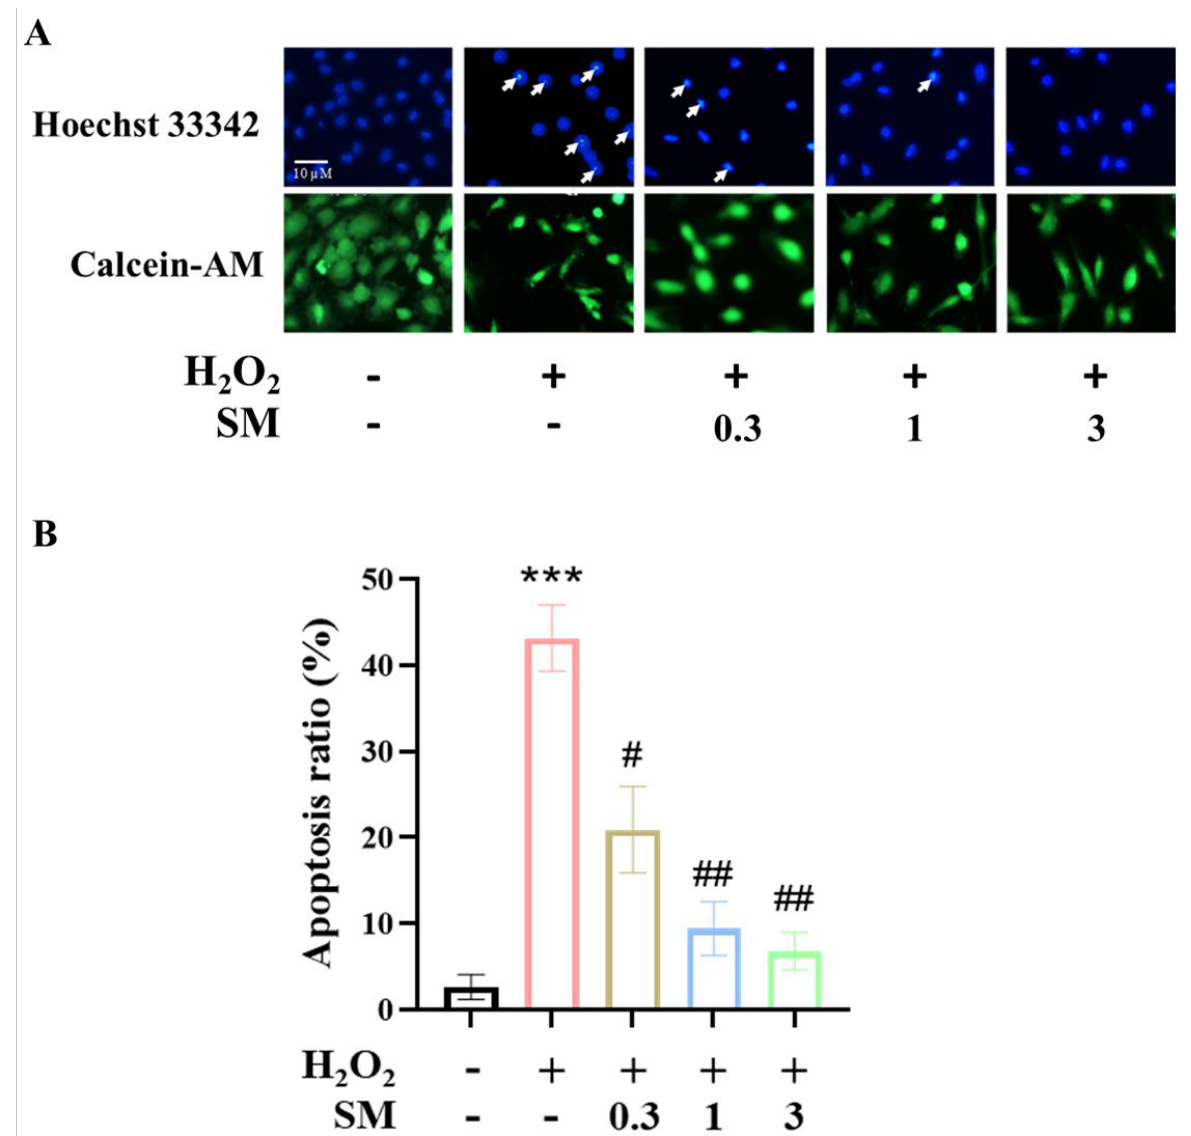
Figure 4. Protective effects of SM against H 2 O 2 -induced apoptosis in HAECs. HAECs were pretreated with SM (0.3–3 µ M) for 30 min, and then incubated with or without 100 µ M H 2 O 2 for 24 h. ( A ) Epifluorescence microscopy images were obtained after staining with Hoechst 33,342 to assess nuclear morphology, and calcein-AM to evaluate membrane integrity. The presence of condensed and fragmented nuclei was considered an indicator of apoptosis (white arrow). ( B ) The mean percent cell apoptosis was evaluated in quadruplicate samples. The p values were determined using Student’s t -test. *** p < 0.001 vs. control group; # p < 0.05, ## p < 0.01 vs. H 2 O 2 -treated cells.